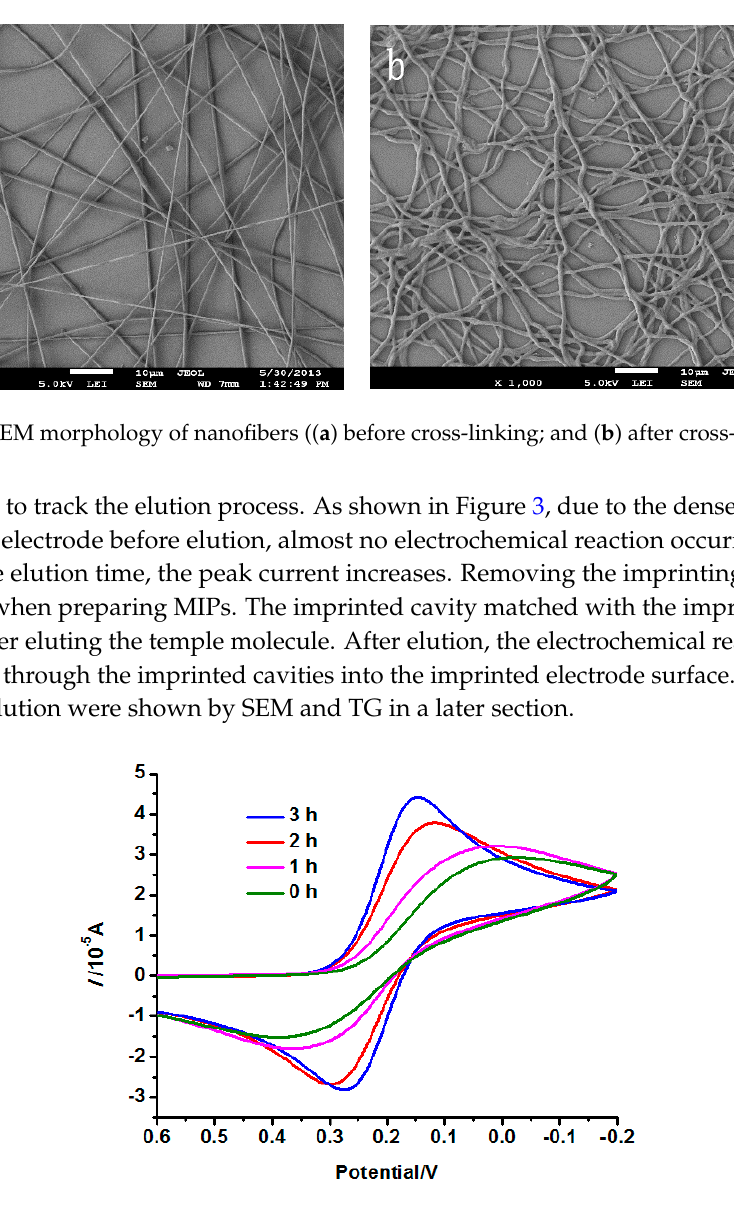
Figure 3. Elution of the molecular imprinted electrode by shaking.